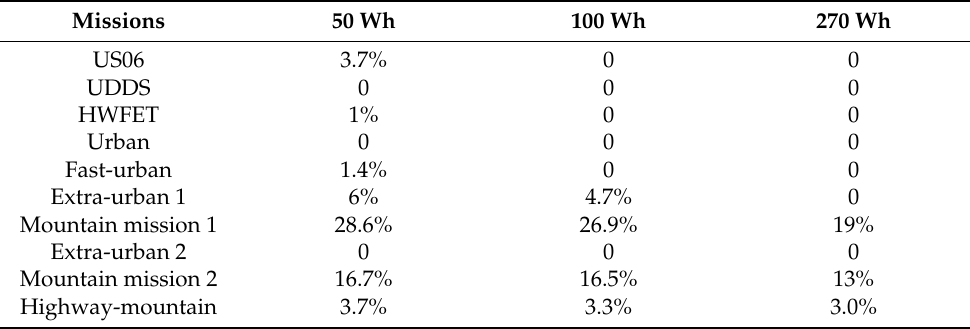
Table 10. Energy wasted on mechanical brakes, expressed as a percentage of the generated energy, for different BZ